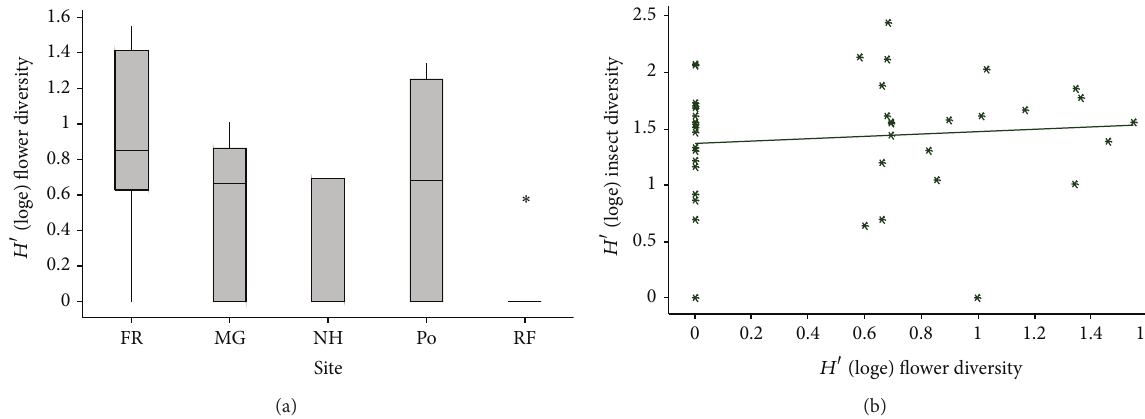
Figure 4: (a) Whiskered Box Plot showing the range of diversity scores. Box indicates median value, lower, and upper quartiles. Whiskers indicate the range. Outliers indicated by an asterisk. Flower Rich Grassland (FR), Mown Grassland (MG), New Hedge (NH), Pond (Po), and Ridge and Furrow Grassland (RF). (b) Scatterplot with line of best fit showing the correlation between shannon Weiner diversity score for insects and